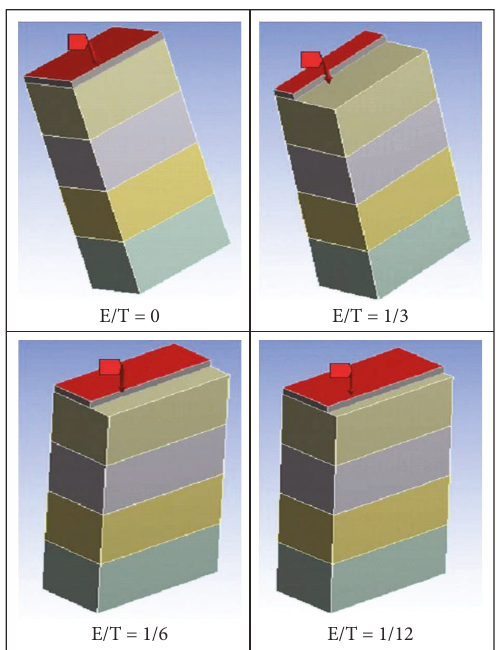
Figure 6: CSRE specimens with H/T � 4 models at different eccentricities.